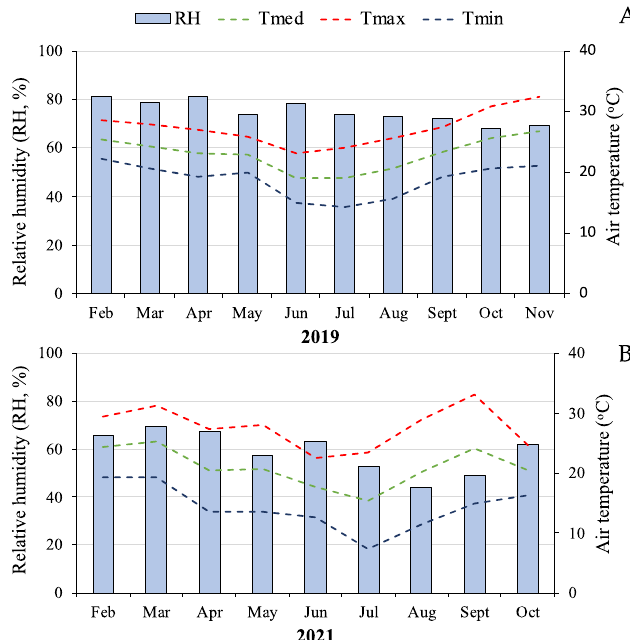
Figure 1. Maximum (Tmax), minimum (Tmin), and average (Tmed) air temperature ( ◦ C) and relative humidity (RH, %) inside a semi-climatized greenhouse at the Instituto de Desenvolvimento Rural do Paran á -IAPAR/Emater, Londrina, PR, Brazil, from February to November 2019 ( A ) and February to October 2021 ( B ).